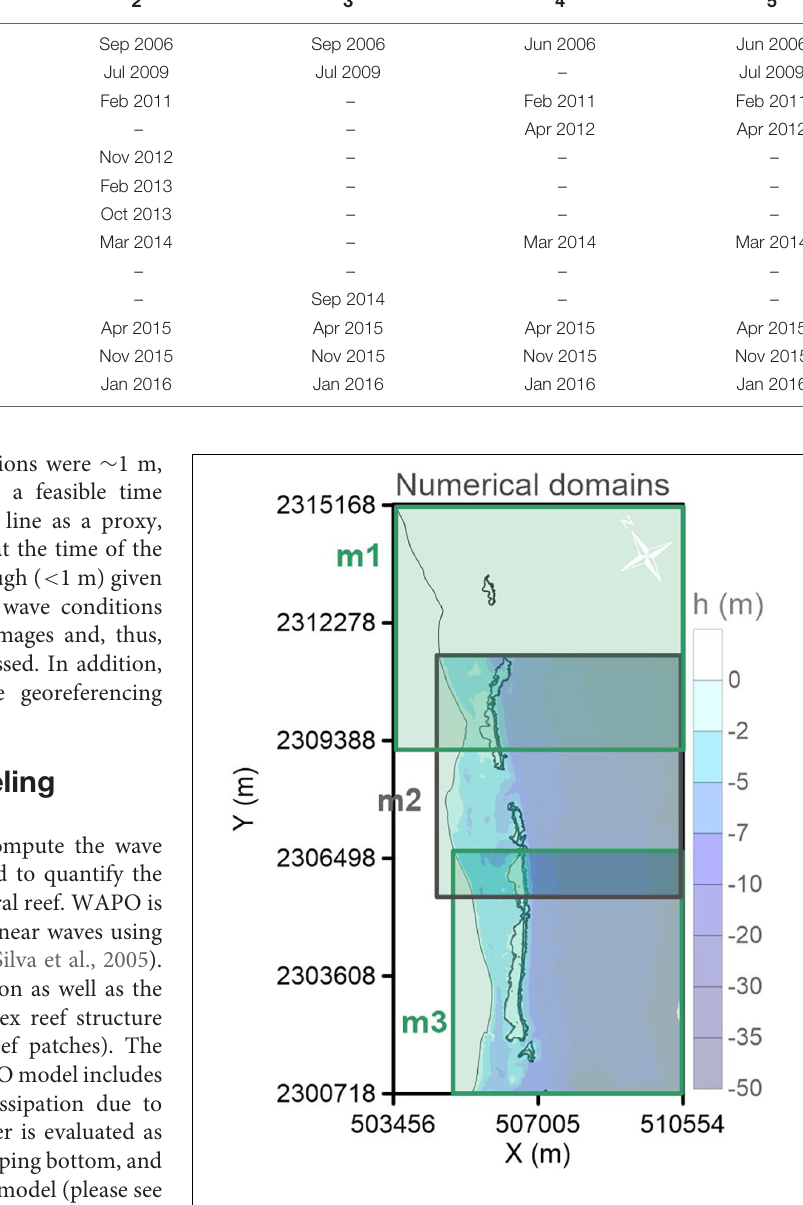
for the same study region. Seagrasses were found to produce only localized effect on wave propagation and almost no effect on beach